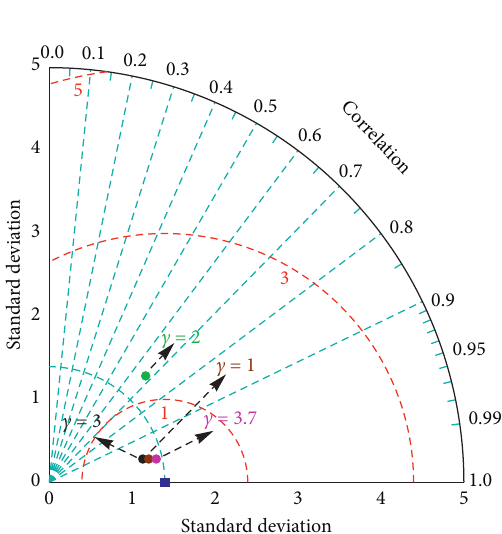
Figure 8: Taylor’s diagram for the model of the upper bounds in Example 1. The rectangle on the x -axis represents the observations, and the red-dashed contours indicate the centered Root Mean Square